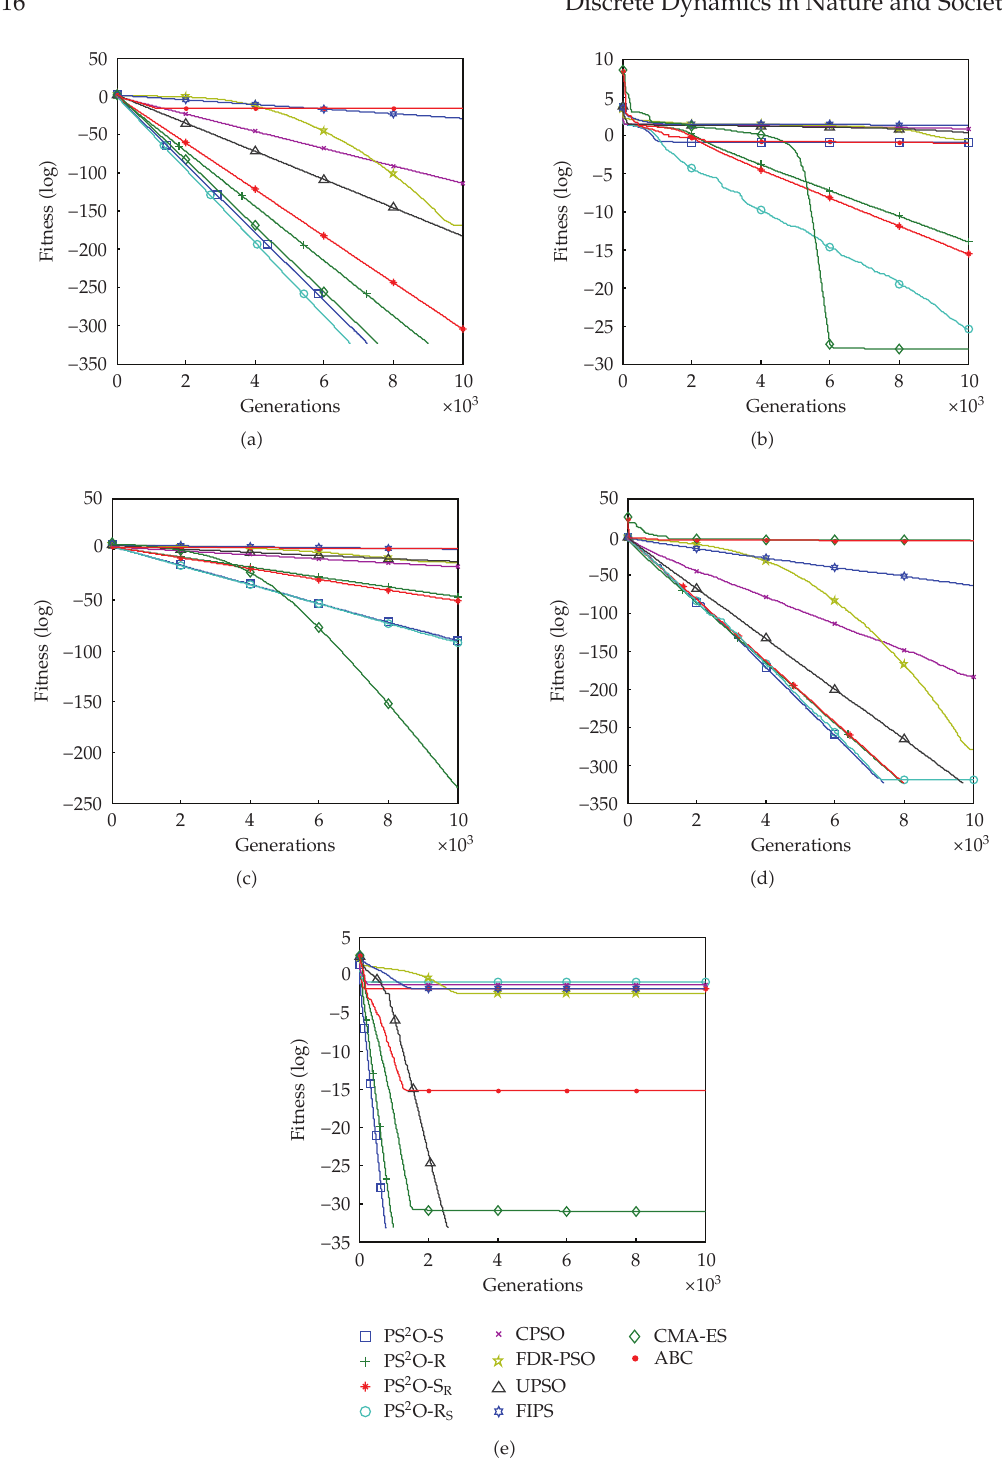
Figure 9: The median convergence results of 30D unimodal continuous functions. (cid:2) a (cid:3) Sphere function. (cid:2) b (cid:3) Rosenbrock’s function. (cid:2) c (cid:3) Quadric function. (cid:2) d (cid:3) Sum of di ff erent powers. (cid:2) e (cid:3) Sin